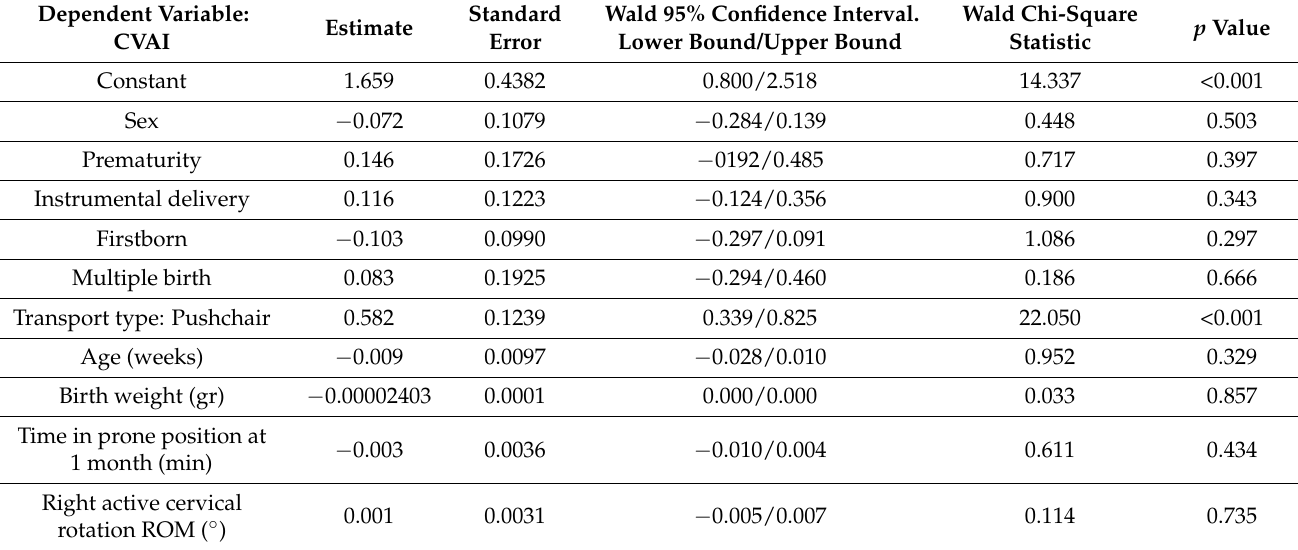
Table 3. Model effects with the right active cervical rotation ROM as a covariate.